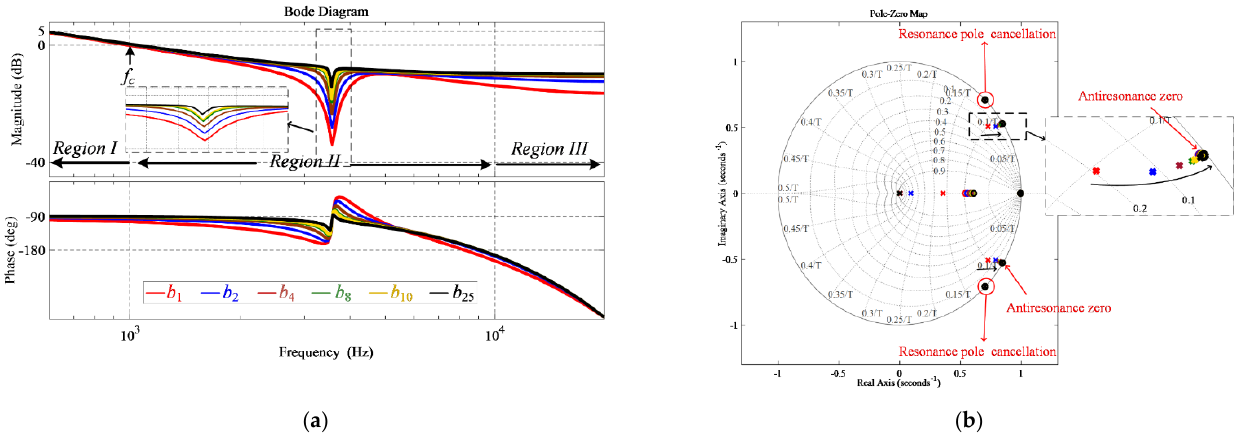
Figure 15. The frequency response of the loop gain using RESO-based ADRC for the LCL filter type GcI under variations in gain parameter b ( a ) Using Bode plot; ( b ) Using pole-zero map.